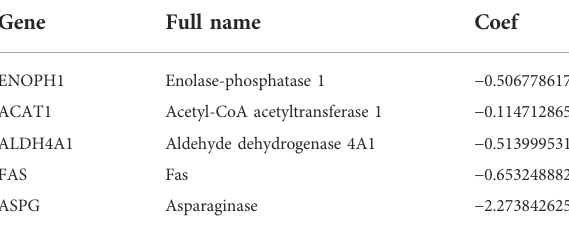
TABLE 2 Prognostic genes generated by LASSO Cox